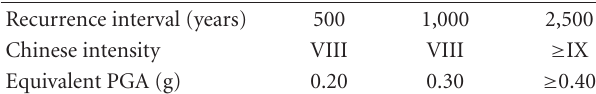
Table 5: Recommended design parameters for the city of